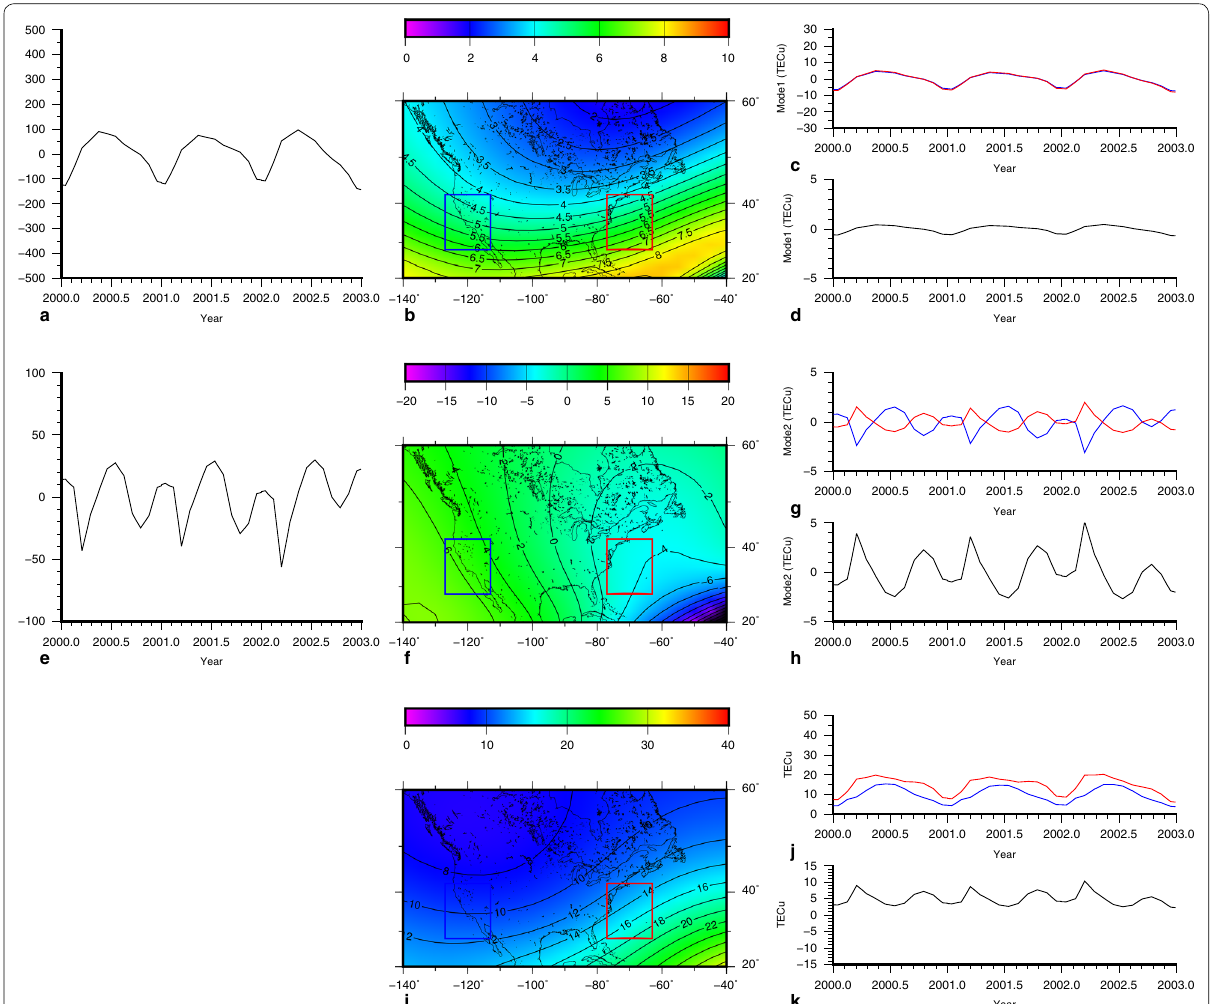
Fig. 11 vTEC IRI over the North American region: a amplitude of the temporal variation, a 1 (the y -axis has to be multiplied by a factor of 10 − 2 ), b eigenvector or spatial variation, e 1 , c synthesized data for mode 1 ( a 1 e 1T ) for red (east) and blue (west) rectangles, d difference between red and blue · curves of Fig. 11c; e the amplitude of the temporal variation, a 2 (the y -axis has to be multiplied by a factor of 10 − 2 ), f eigenvector or spatial variation, e 2 , g synthesized data for mode 2 ( a 2 e 2T ) for red (east) and blue (west) rectangles, h difference between red and blue curves of Fig. 11g. Finally, the · time-averaged vTEC IRI ( x ) ( i ), the synthesized data, j vTEC ∗ IRI ( t ) , for red (east) and blue (west) rectangles, and the difference ( dvTEC and blue curves of Fig. 11j ( k